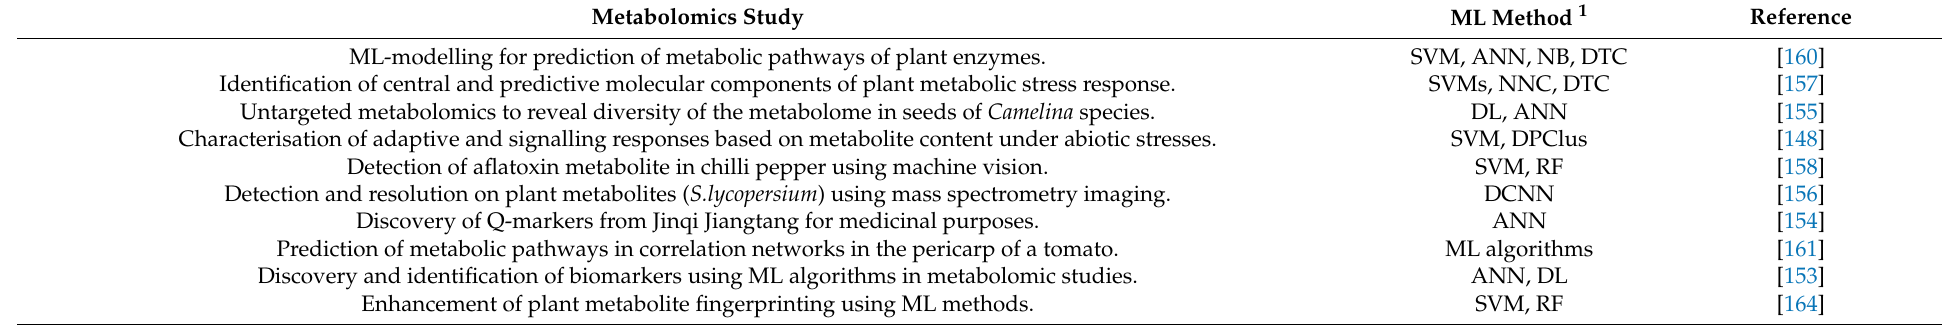
Table 2. Selected recent metabolomics studies showcasing 4IR technologies, particularly the use of ML methods in plant research. Metabolomics Study ML-modelling for prediction of metabolic pathways of plant enzymes. Identification of central and predictive molecular components of plant metabolic stress response. Untargeted metabolomics to reveal diversity of the metabolome in seeds of Camelina species. Characterisation of adaptive and signalling responses based on metabolite content under abiotic stresses. Detection of aflatoxin metabolite in chilli pepper using machine vision. Detection and resolution on plant metabolites ( S.lycopersium ) using mass spectrometry imaging. Discovery of Q-markers from Jinqi Jiangtang for medicinal purposes. Prediction of metabolic pathways in correlation networks in the pericarp of a tomato. Discovery and identification of biomarkers using ML algorithms in metabolomic